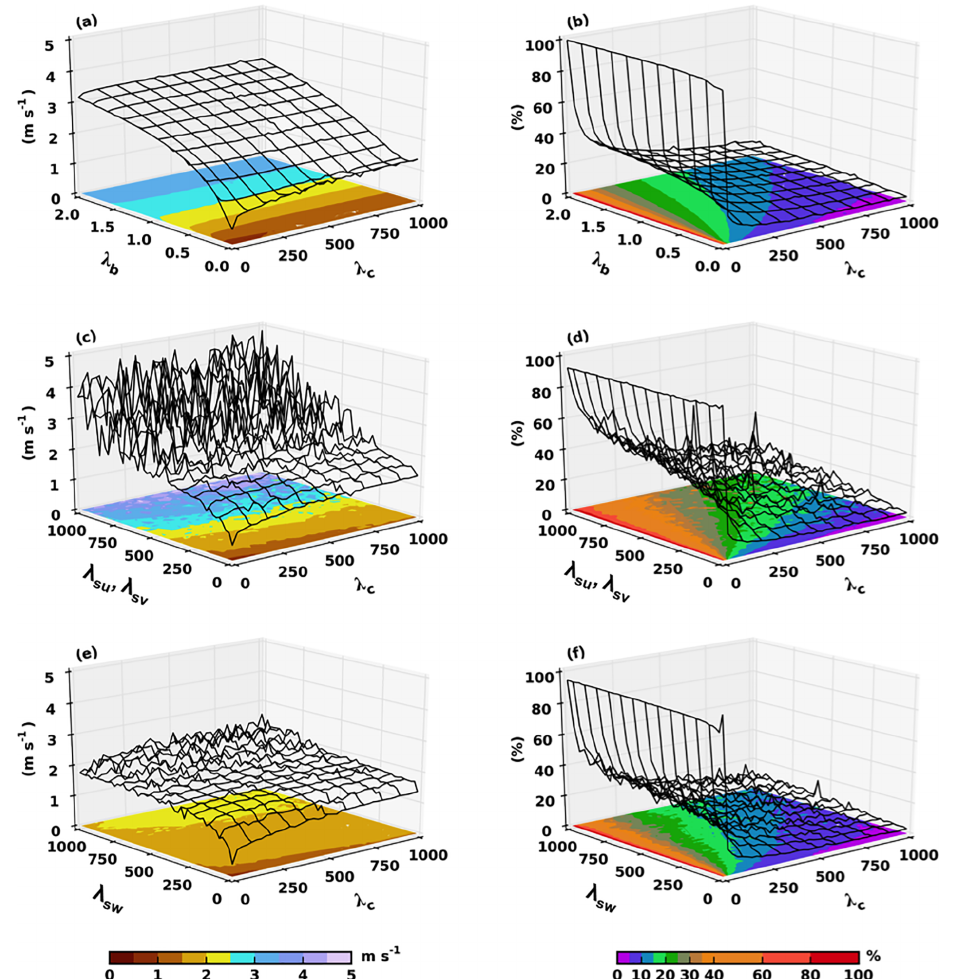
Figure 4. 3DVAR constraint weight sensitivity analysis for two metrics: CSAPR-I7 radial velocity RMSD (left column) and NMCR (right column). Sensitivity analysis is performed by perturbing (a, b) λ c versus λ b and (c, f) λ c versus λ s u , λ s v , and λ s w constraint weights. The nominal values for weights not being tested in a given panel are set to those used in previous OSSE studies (see Table